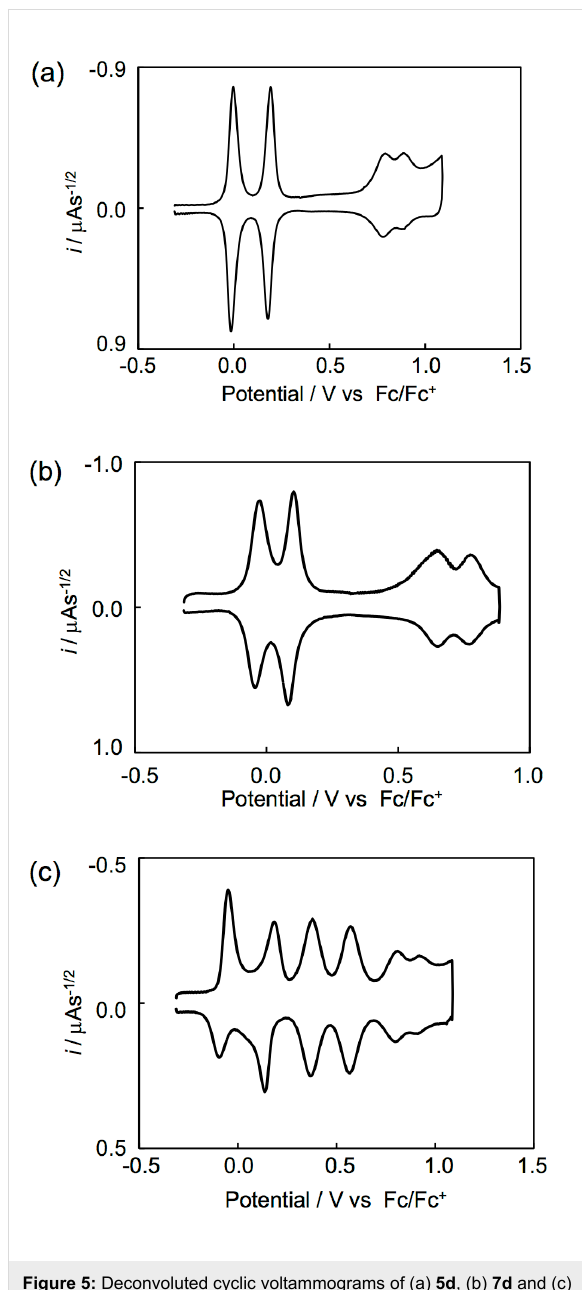
Figure 5: Deconvoluted cyclic voltammograms of (a) 5d , (b) 7d and (c) 9d .